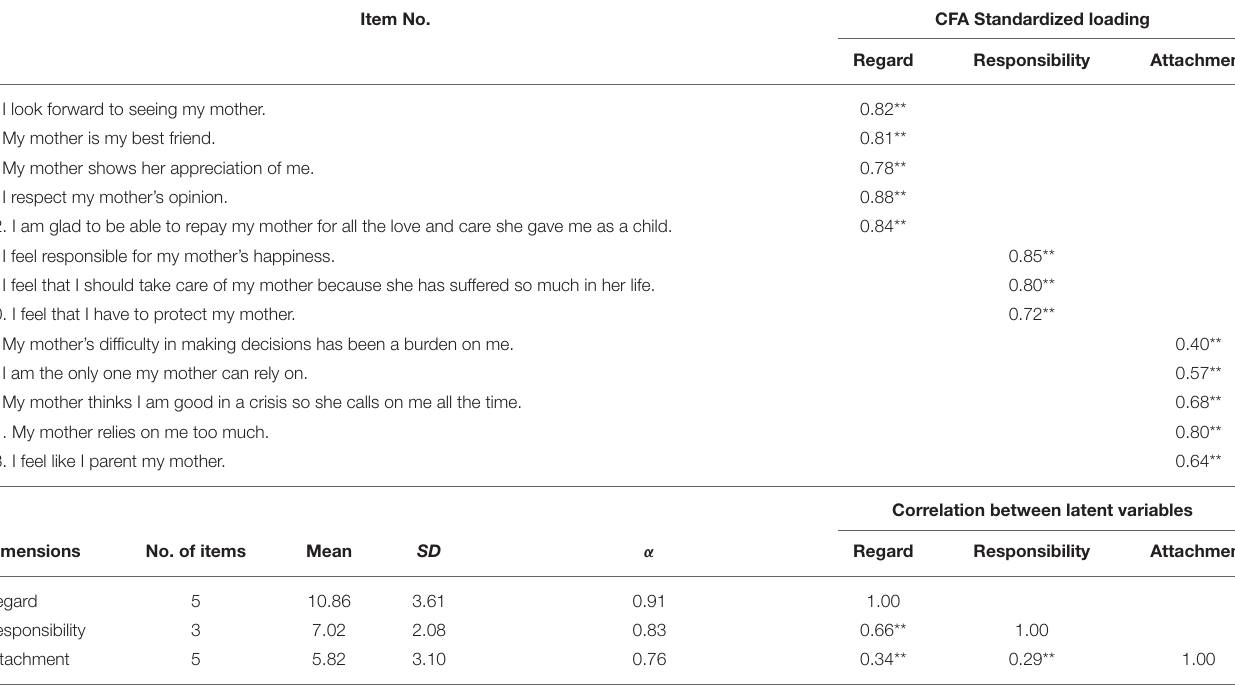
TABLE 7 | Confirmatory factor analysis and factor correlations based on responses to the PACQ for mother. Item